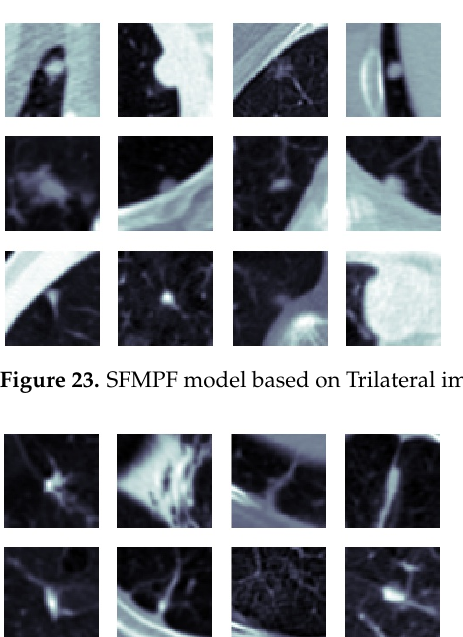
Figure 22. SFMPF model using Trilateral image—comparison of ROC curve for slice, perspective, and volume-level classifications for the slices from YZ-perspective.